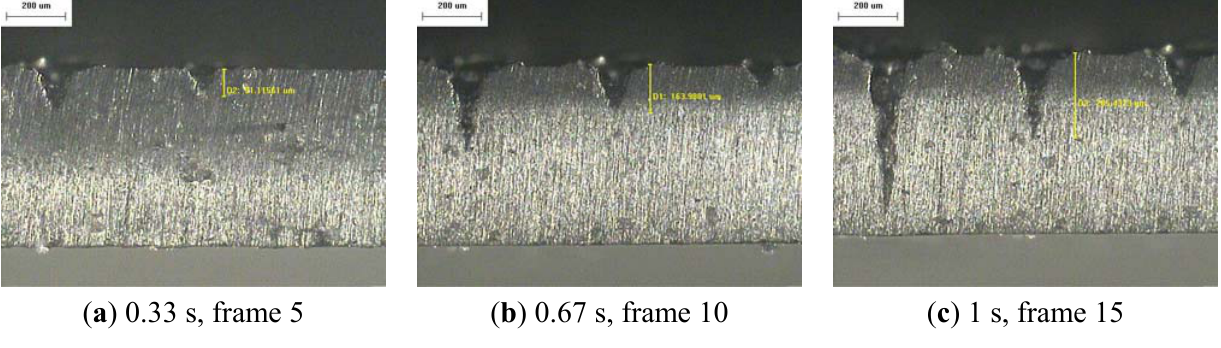
Figure 6. Workpiece (Al 5052) profile images at different process times (radiation energy is 175 mJ): ( a – e )